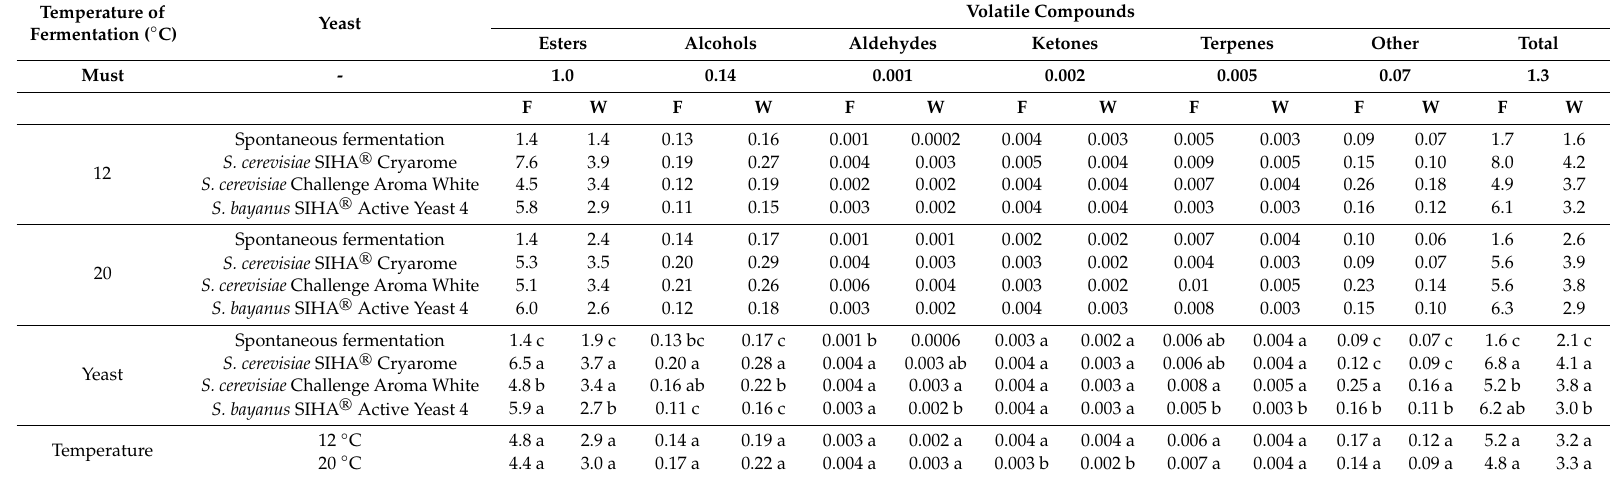
Table 3. Aroma of Aurore wine and must as a group of volatile compounds (mg /